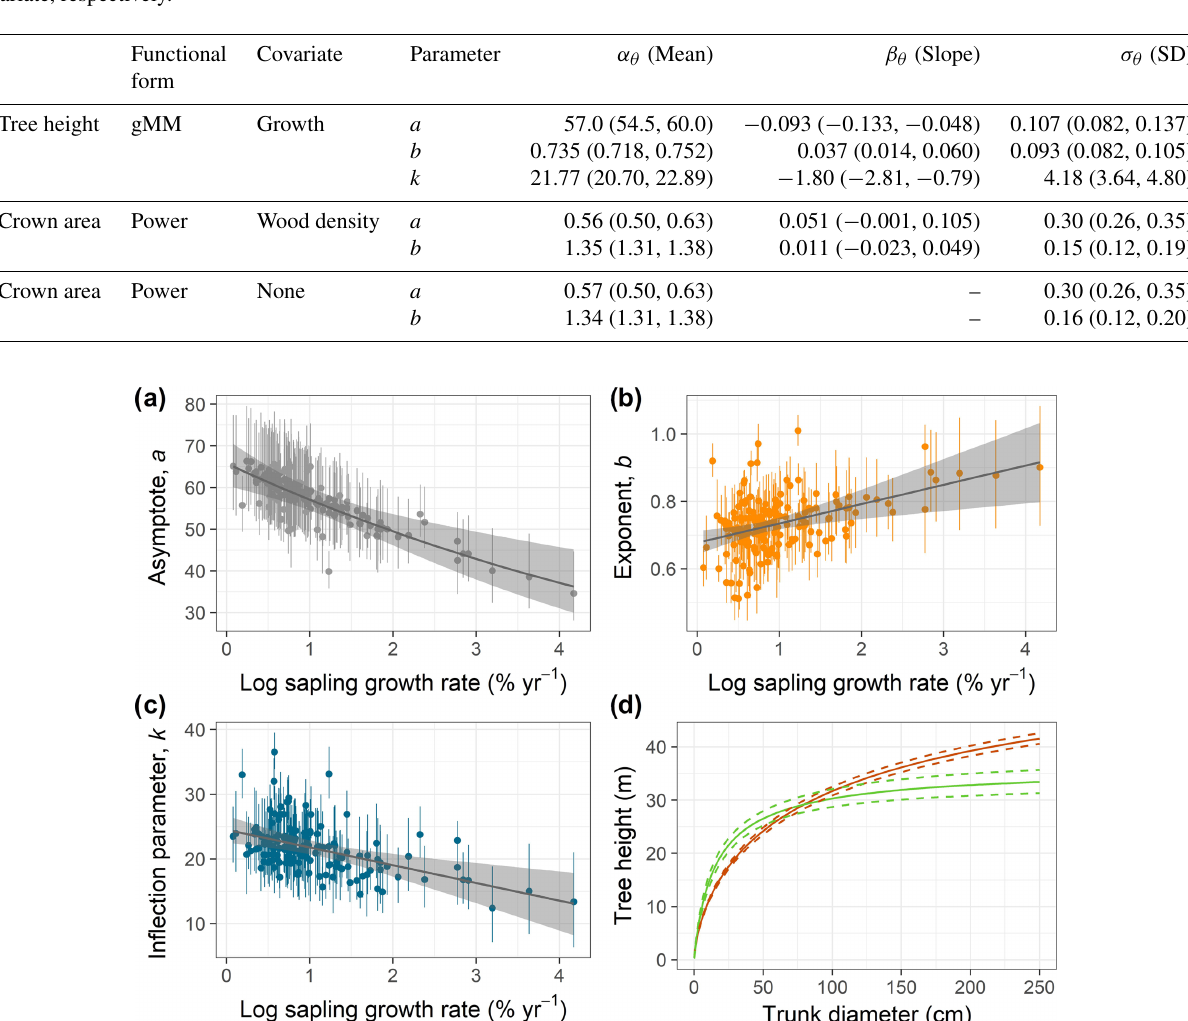
Figure 2. (a–c) Relationships of species-specific tree height allometry parameters with log-transformed mean sapling relative growth rate in the best-fit hierarchical model, which incorporated the generalized Michaelis–Menten function (Eq. 3). Points show median posterior estimates for each species, with vertical bars indicating 90% posterior central intervals. The thick grey line depicts the fitted relationship across species, and the shaded envelope encloses the 90% posterior interval. (d) Illustration of interspecific differences in tree height scaling in the fitted model, with the red line showing predictions for the lowest sapling growth rate (very high shade tolerance) and the green line showing the highest sapling growth rate (very low shade tolerance), together with their 90% credible intervals (dashed lines).